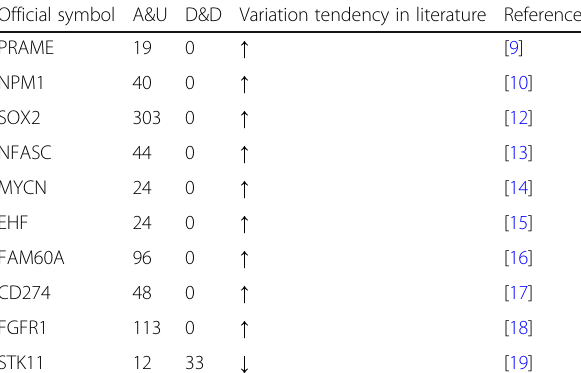
Table 2 Variation tendency revalidation of genes with a significant correlation between CNV and differential gene expression in